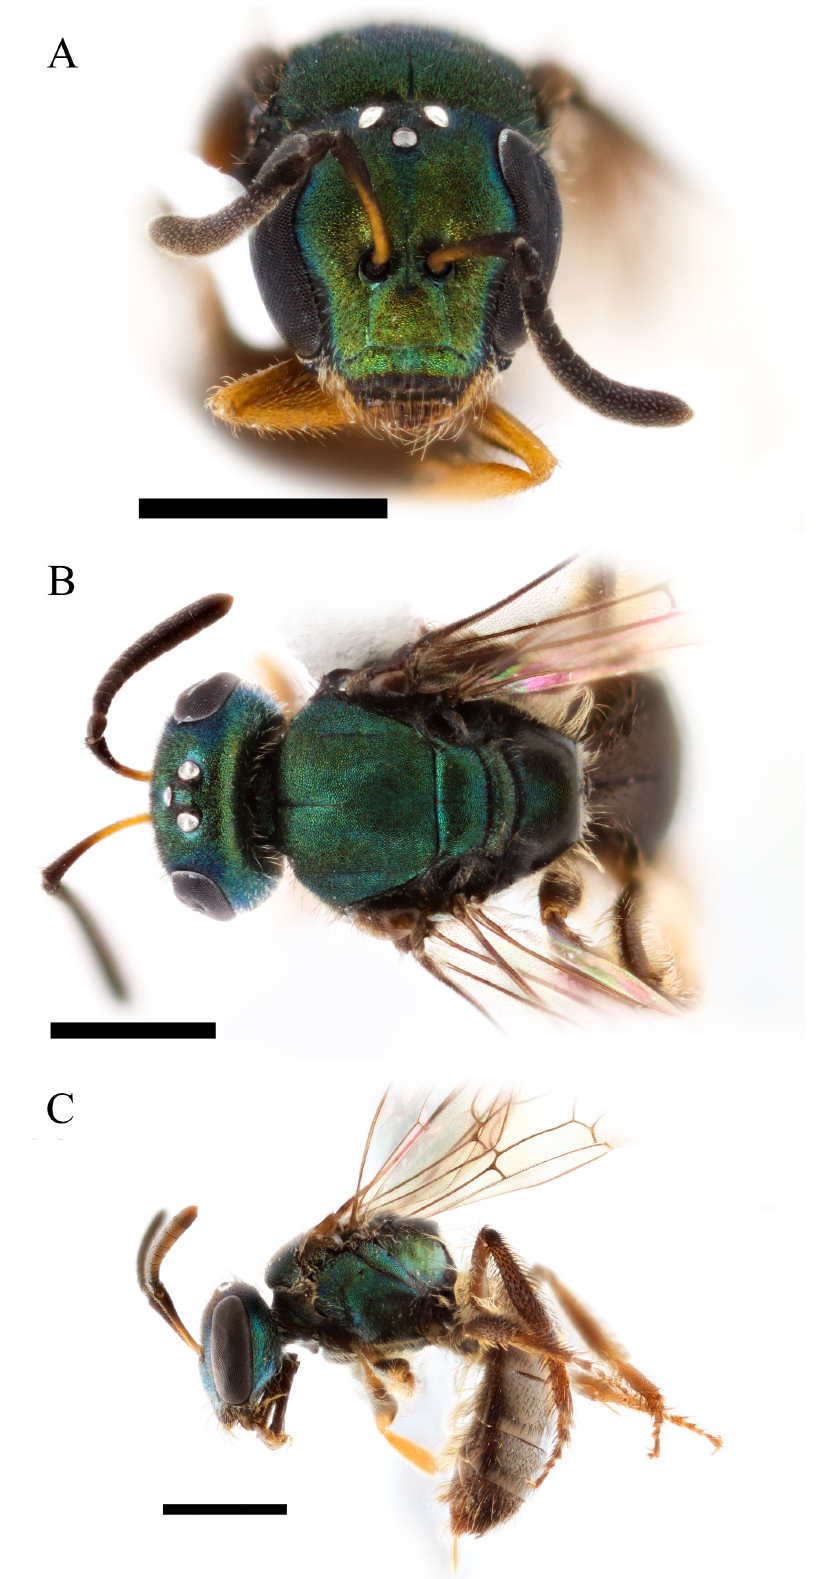
Fig. 20. Habralictus gonzalezi Gibbs, 2012, ♀. A . Face. B . Lateral habitus. C . Dorsum of mesosoma. Scale bars = 1